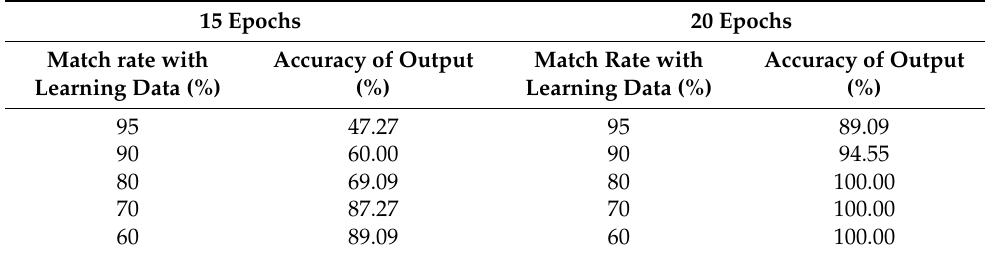
Table 3. The accuracy of the CNN model.